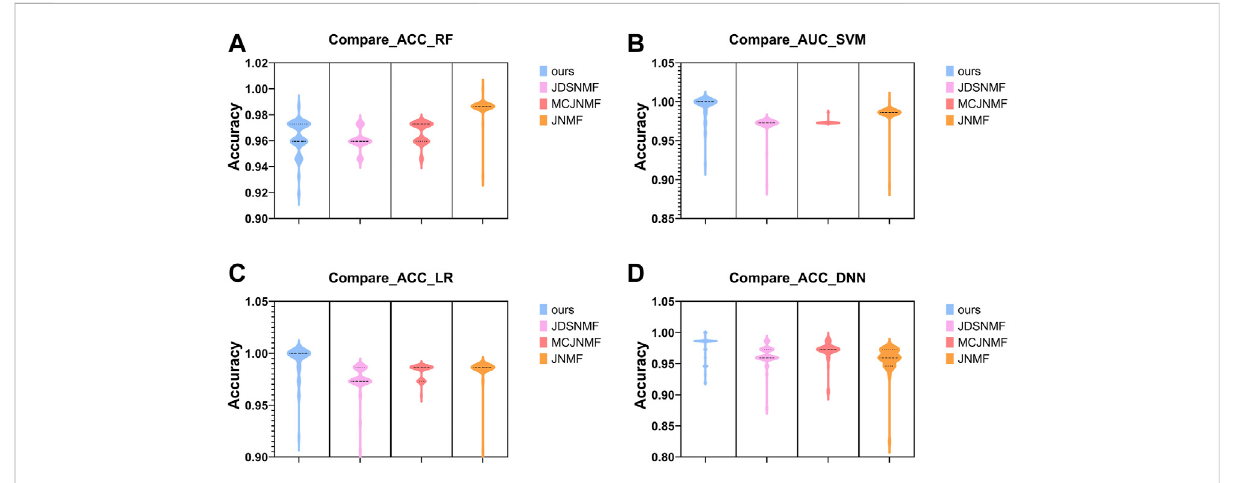
FIGURE 12 Violin plots for AUC using four classi fi ers to classify the features of the four algorithms in their respective signi fi cant modules. (A – D) . The comparison results obtained using RF, SVM, LR, and